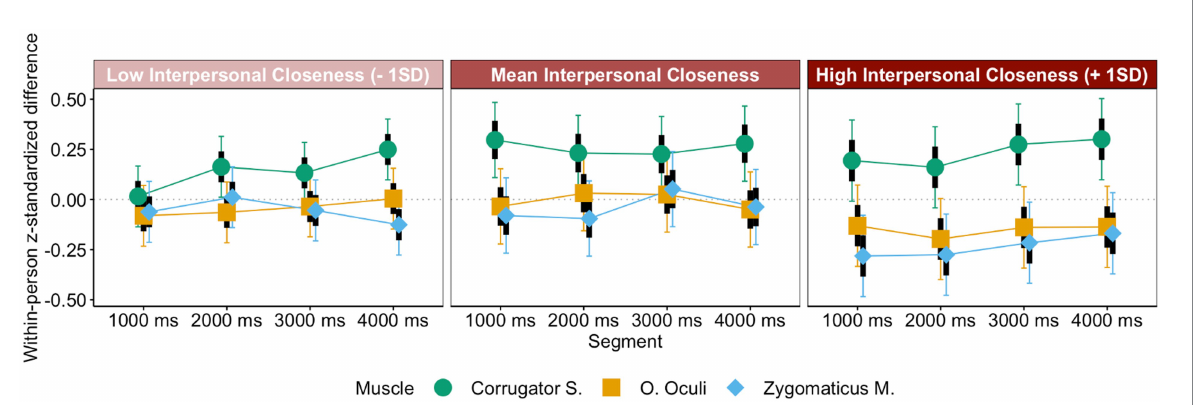
FIGURE 6 Sadness mimicry as a function of interpersonal closeness, segment, and muscle.